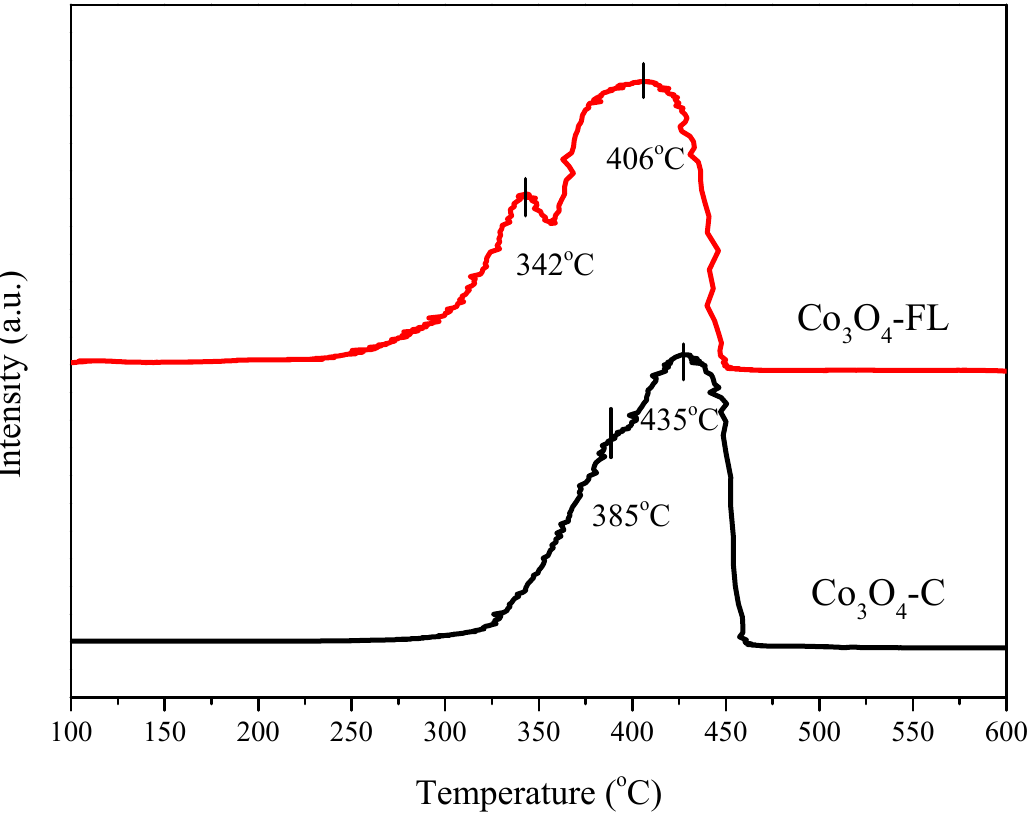
Figure 3. H 2 -TPR profiles of the Co 3 O 4 -FL and Co 3 O 4 -C catalysts. The O 2 -TPD of catalysts was carried out to evaluate the mobility of oxygen species, as shown in Figure 4. Generally, there are four oxygen species on the surfaces of metal oxides, with the release order: O 2 (molecular oxygen) → O 2 − (superoxide anion) → O − (oxygen anion) → O 2 − (lattice oxygen). The physically adsorbed O 2 species can be desorbed below 200 ◦ C. The O 2 − and O − species are chemically adsorbed oxygen, which can be liberated in the range of 200–400 ◦ C. The rest of the O 2 − species are attributed to surface and/or lattice oxygen released above 400 ◦ C [18]. It seems that the Co 3 O 4 -FL catalysts present desorption peaks at 206 and 345 ◦ C, which can be attributed to the desorption of O 2 − and O − species, respectively, whereas another peak is located at 415 ◦ C, which can be assigned to the desorption of O 2 − species. The desorption temperature of the Co 3 O 4 -C catalysts shifts from 206 to 257 ◦ C, and from 415 to 482 ◦ C, respectively, indicating that the desorption of O 2 − , O − , and O 2 − species was facilitated, implying an enhancement in the catalytic activity of Co 3 O 4 -FL through a suprafacial mechanism.